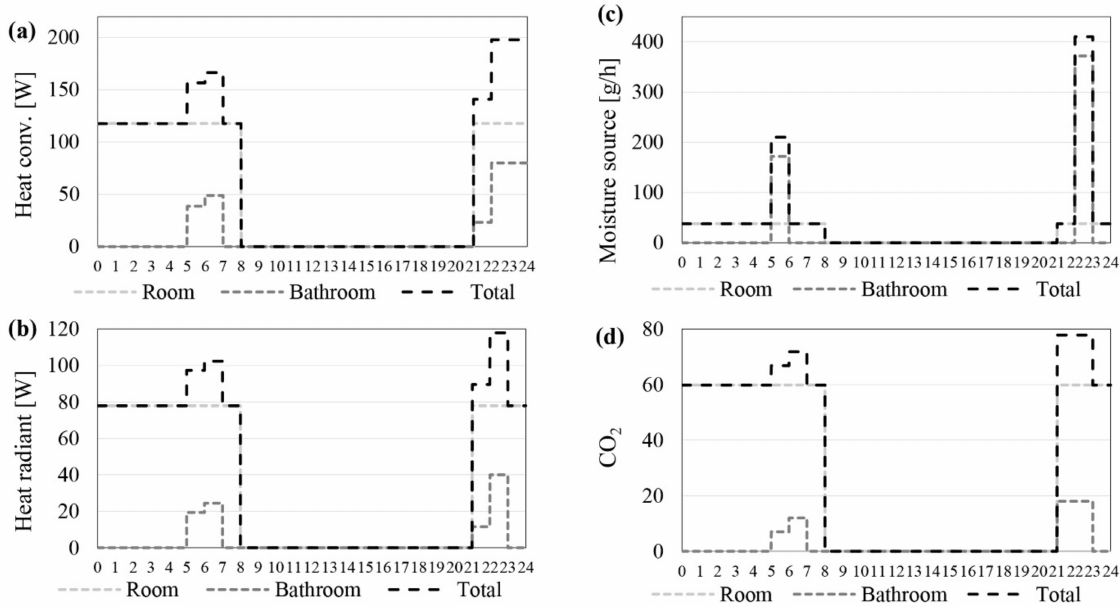
Figure 5. Internal load profiles ( a ) Heat gains convective; ( b ) Heat gains radiant; ( c ) Moisture source; ( d ) CO 2